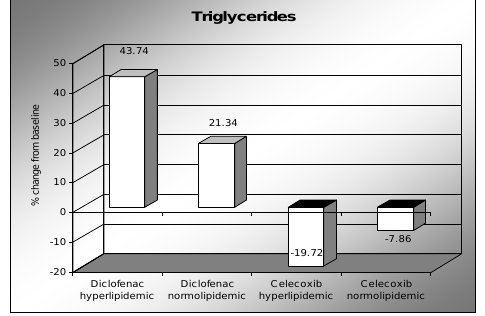
Figure (2) :- The % changes in serum triglycerides concentration frombaseline value after 8weeks treatment with diclofenac or celecoxib in hyperlipidemic and normolipidemic type 2 diabetic patients